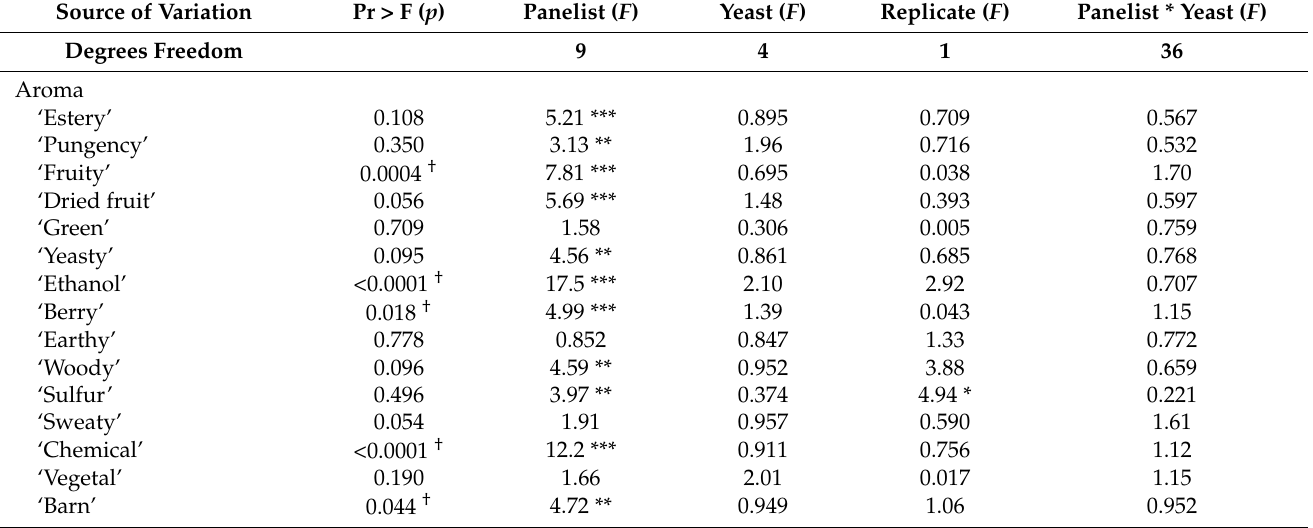
Table 2. Significance and F ratios from analysis of variance of trained panel evaluations of aroma, taste, mouthfeel, and flavor sensory attributes in Merlot wines inoculated with or without non- Saccharomyces yeasts followed by S. cerevisiae